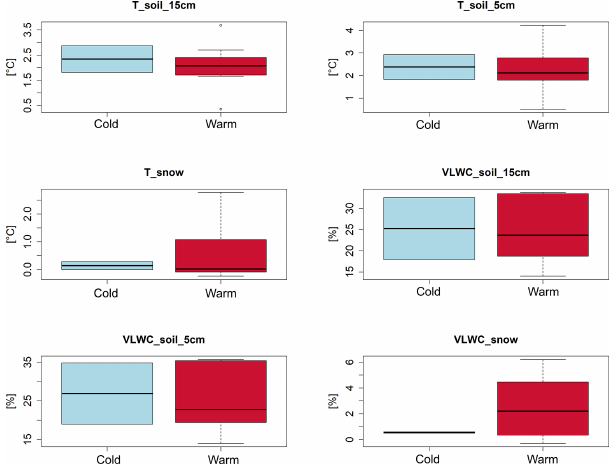
Figure 8. Box plots of the parameters registered at the moment of the cold and warm glide-snow avalanche events (values registered 30min before the